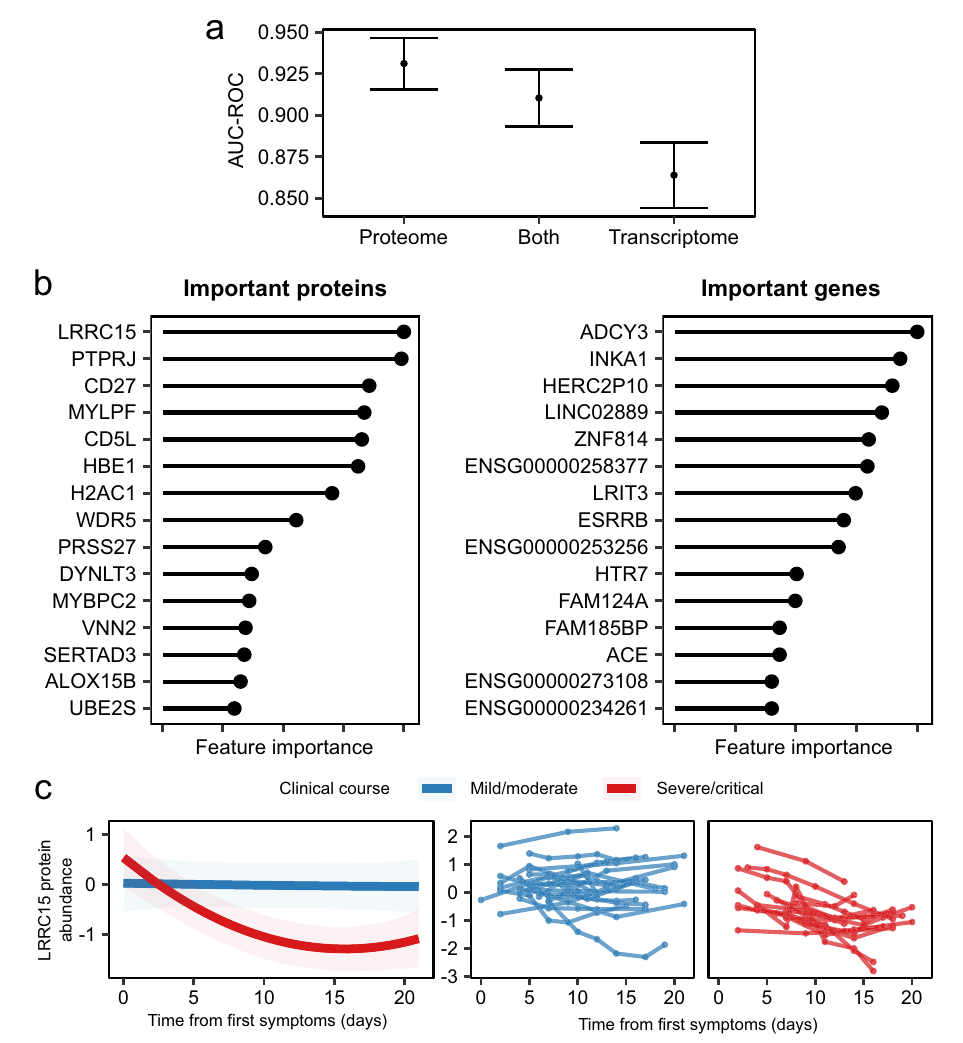
Fig. 6 | Supervised learning to predict COVID-19 severity from molecular fea- tures. a Point estimates (mean) and 95% con fi dence intervals of the area under the receiver operating characteristic curve (AUC-ROC) for predicting COVID-19 severity (from 200 cross-validation resamples of 51 independent samples) using lasso regression. Both = supervised learning on the combined proteomic and transcriptomic data. b Important proteins (left) and genes (right) for the lasso